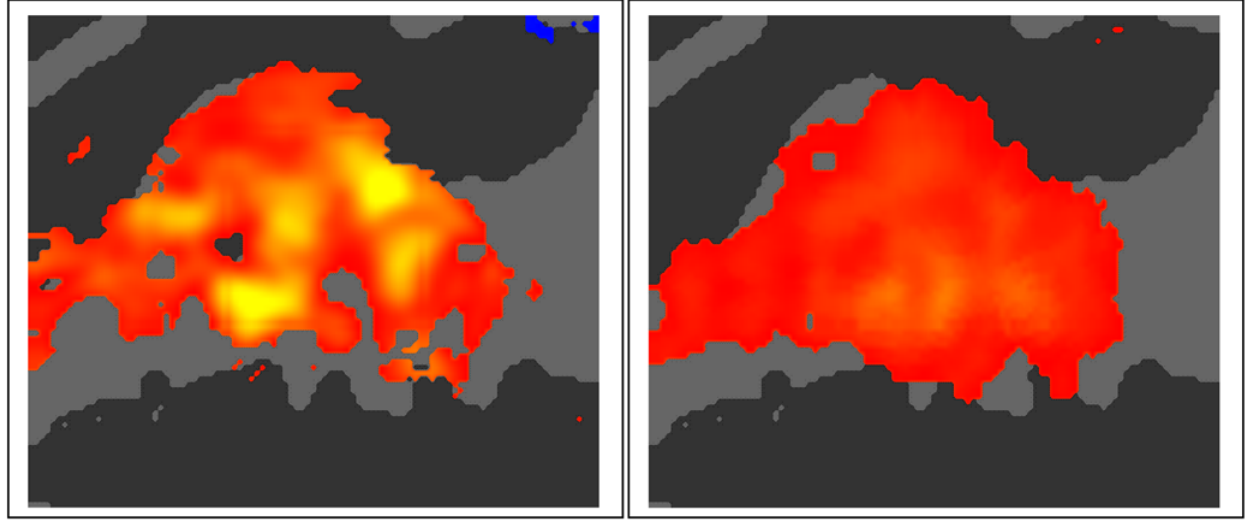
Figure 10. Effects of image acquisition parameters. Stimulus dependent activations in sparse (left) and continuous (right) sampling conditions averaged over tone parameters, hemispheres and subjects. Scale ranges from 0.1% (red) to 1.0% (yellow) combined with a z . 3.0 mask.